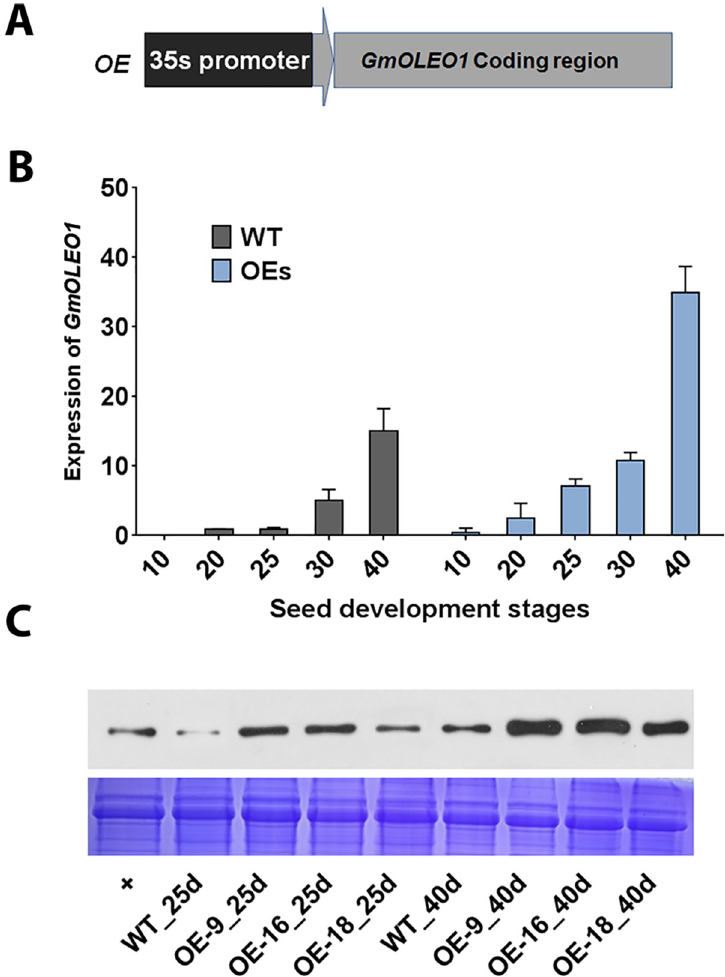
Fig 3. Expression analyses of GmOLEO1 in transgenic plants. A, Diagram of the plasmid construct (35S:: GmOLEO1 ) that was used for soybean transformation. B, Expression analysis of GmOLEO1 in developing seeds (10, 20, 25, 30, 40 DAF) of T 3 homozygous OE lines and the wild type (WT). C, Western blot image showing the expression pattern of GmOLEO1 protein between WT and OE seeds at 25 and 40 DAF. Protein bands were detected by Coomassie blue staining (CBB, bottom) or Western blot (WB, top) probed with antibodies to GmOLEO1.